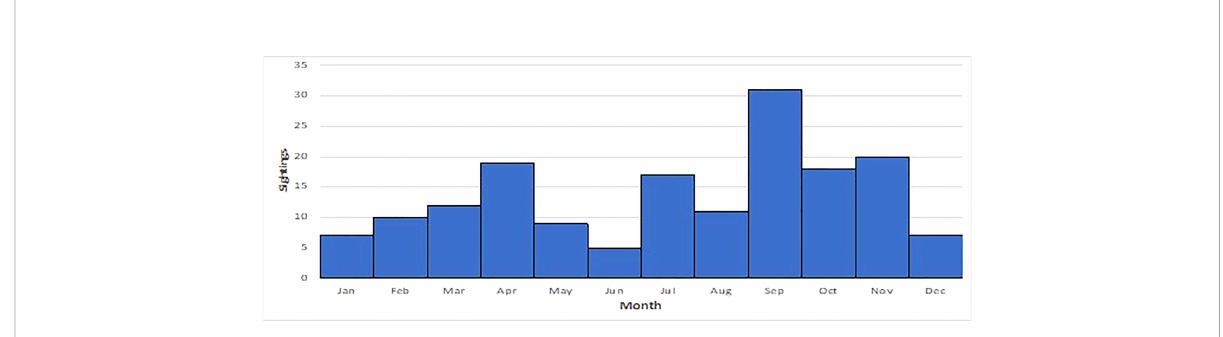
FIGURE 3 Frequency of false killer whale sightings by month (2005 to 2021).